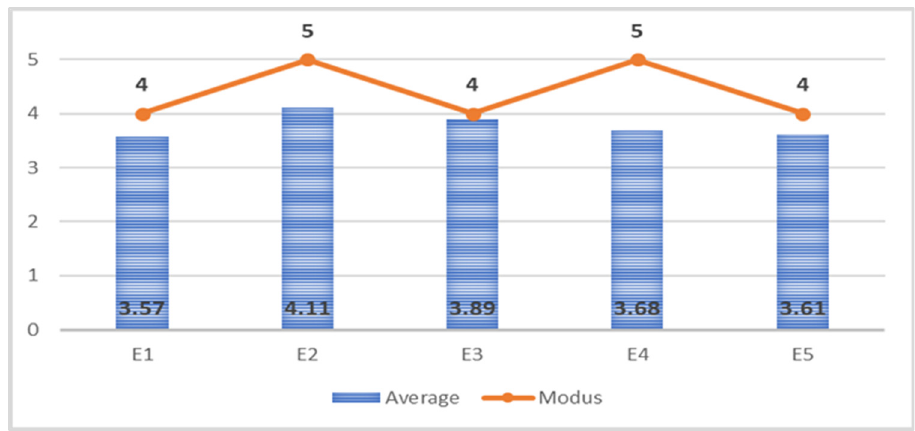
Figure 1. Position characteristics evaluating efficiency. Source: own research, own processing.